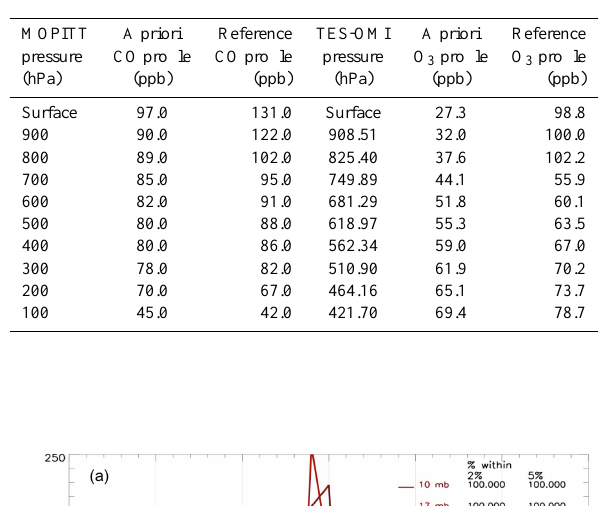
Table 4. A priori and reference profiles for evaluating CO and O 3 errors in predicted or CONUS average AKs.